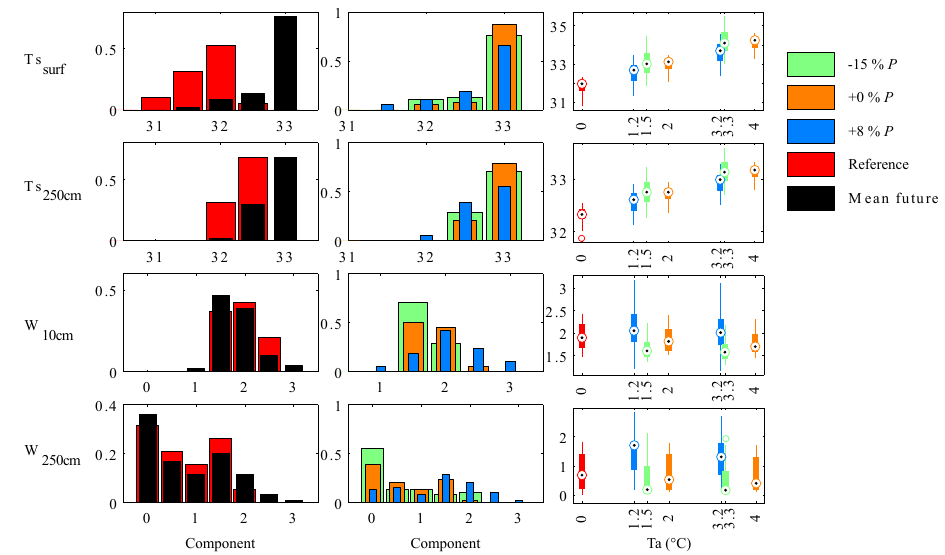
Figure 3. Same as Fig. 2 for soil temperature at the surface and at 250cm, and soil moisture at 10 and